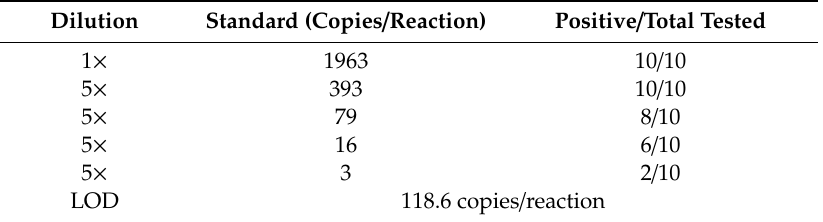
Table 2. Limit of detection (LOD) of the novel SARS-CoV-2 RT-LAMP